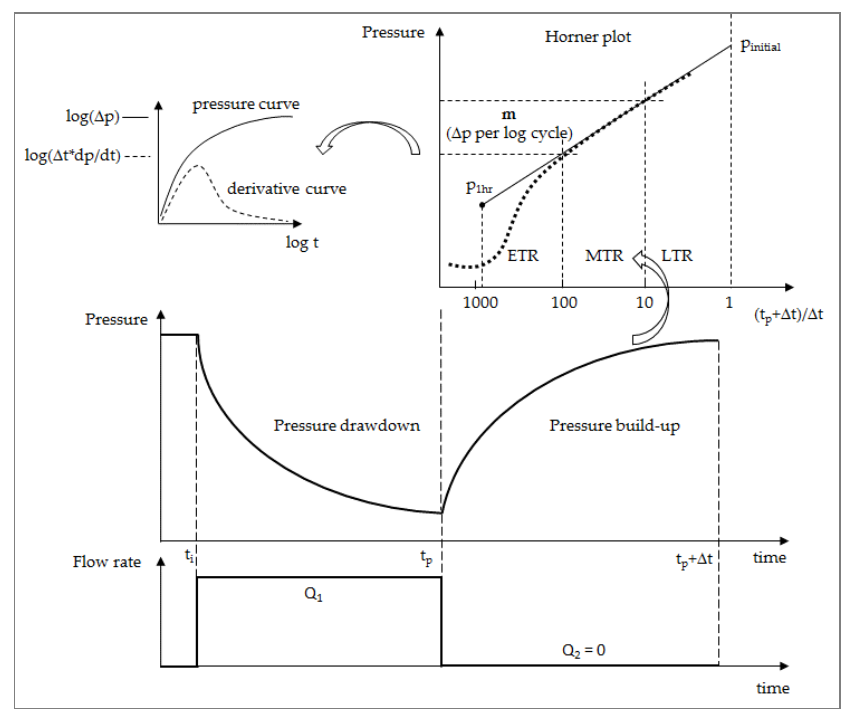
Figure 1. Typical plot of pressure response during well testing and application of Horner’s method.